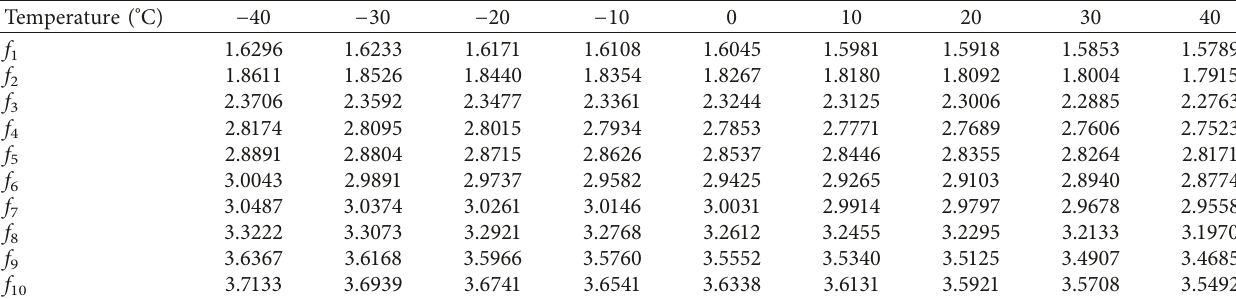
Table 3: Frequency of the first 10 vibration modes of the CSBV with steel wire rope cables (unit: Hz). Temperature ( ° C)